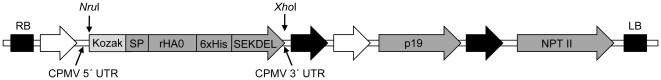
Schematic diagram of the pEAQ-HT-HA plant expression system construct used for agro-infiltration.The entire T-DNA region is shown (not to scale): Black boxes, T-DNA borders (RB, right border; LB, left border); white arrows, CaMV 35S promoters; grey arrows, open reading frames; black arrows, Nos terminators; and NPTII, neomycin phosphotransferase II gene.